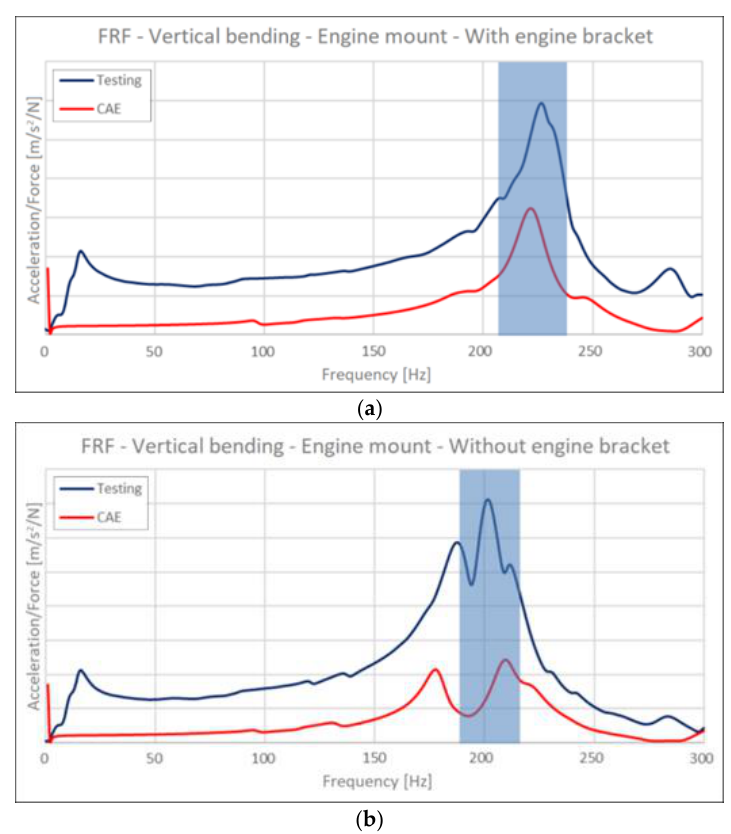
Figure 6. Numerical/experimental comparison on the acceleration/force ratio measured at the engine mount for the vertical bending load case: ( a ) with and ( b ) without the crankcase–gearbox bracket shown in Figure 3. shown in Figure